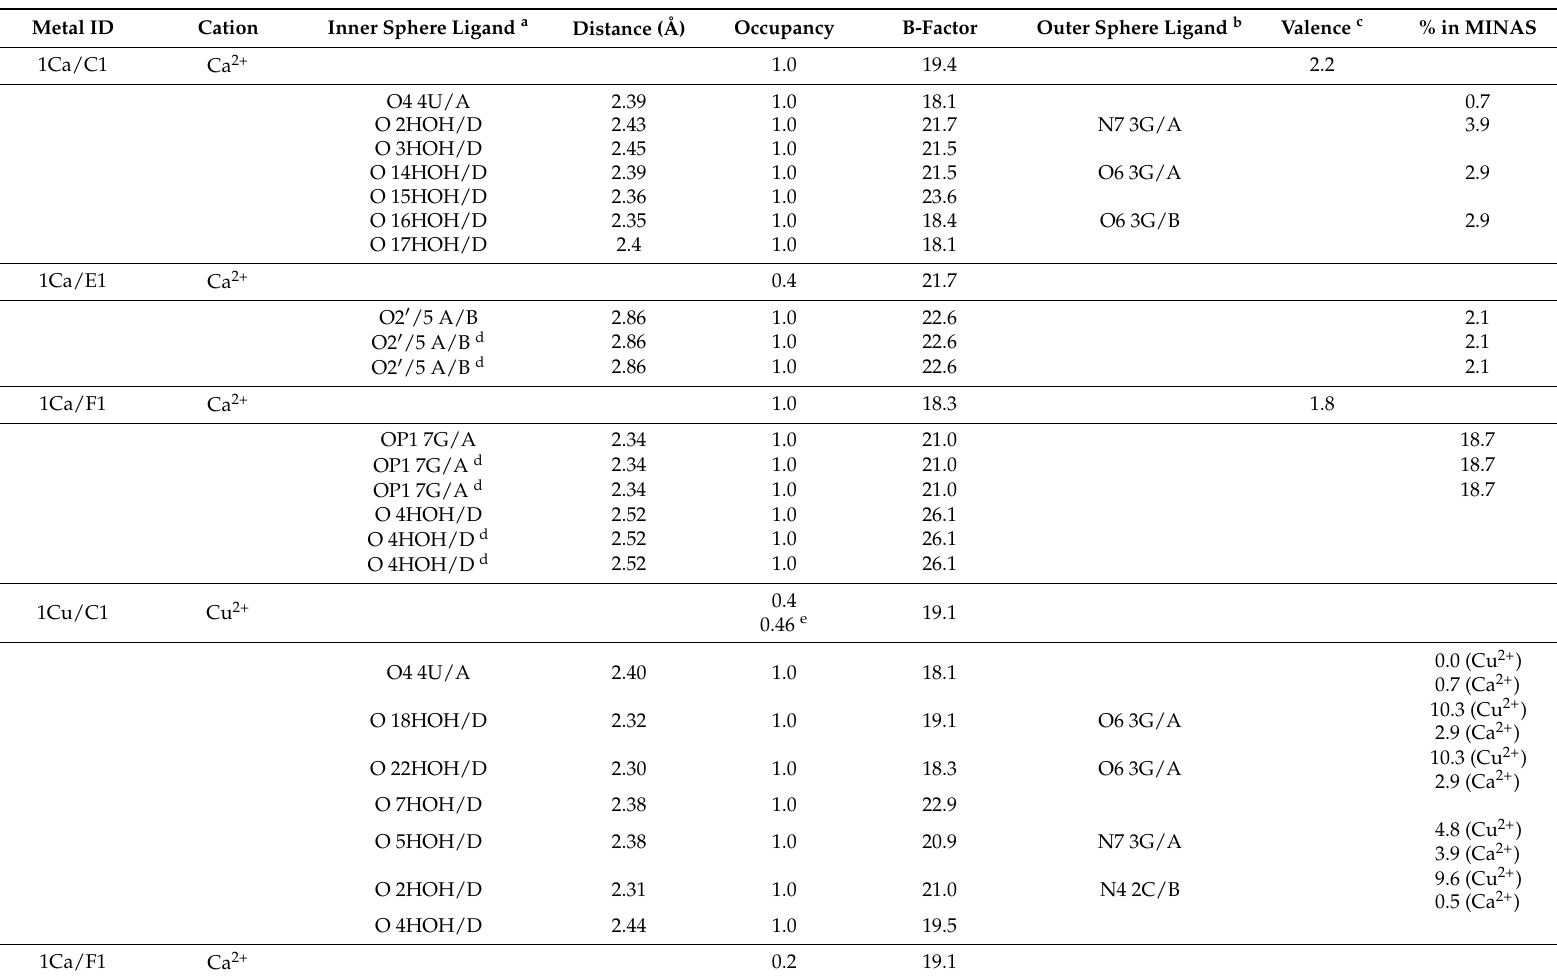
Table 2. Coordination of metal ions in the octameric RNA and comparison of observed RNA metal ion interactions to frequency reported in the MINAS database ( M etal I ons in N ucleic A cid S )